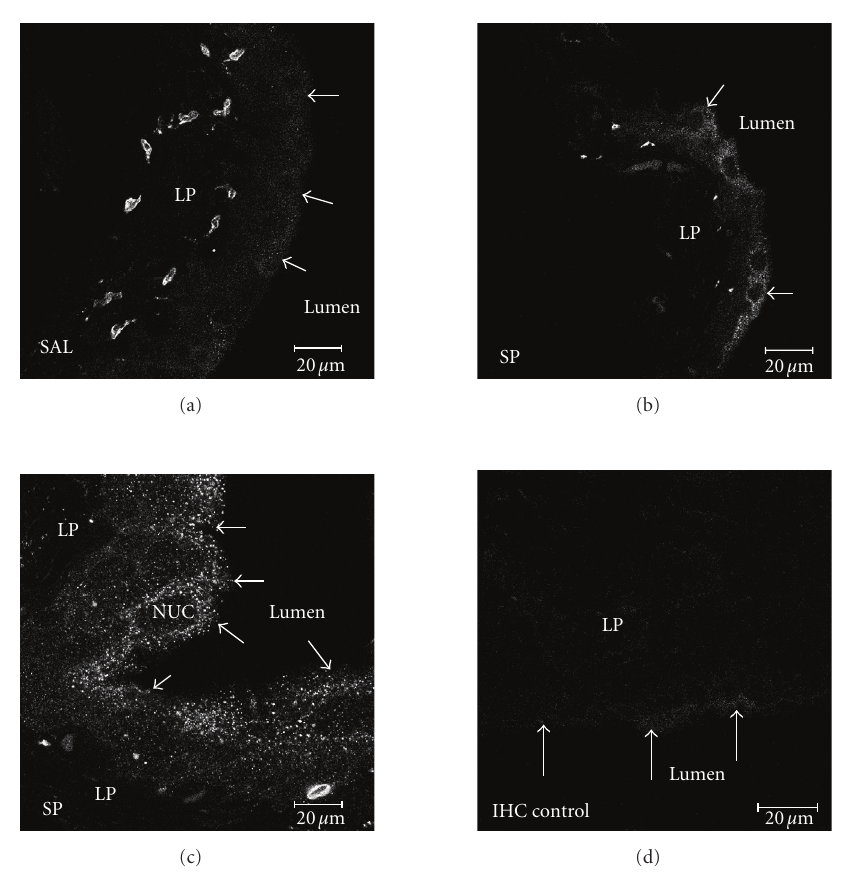
Figure 5: CD74 confocal microscopy. Frozen bladder sections (14 μ m; intact bladders) were exposed to CD74 antiserum and visualized using secondary antiserum labeled with FITC or TRITC. Control experiments included omission of the primary antiserum (panel D). (a) Saline-treated bladder with 40 × objective. (b) SP-treated bladder with 40 × objective. (c) SP-treated bladder with 100 × objective. (d) Saline- treated bladder with 40 × objective, secondary antibody only. Excitation wavelength of 488 nm wasused and emission wavelength of 505 nm and up was collected. Frame size of the image for (a), (b), and (d) is 230.3 μ m × 230.3 μ m; optical thickness of the images is 2 μ m. Frame size of the image for (c) is 92.1 μ m × 92.1 μ m; optical thickness of the image is 0.9 μ m. LP: lamina propria; NUC: nucleus; arrows indicate luminal surface of urothelial